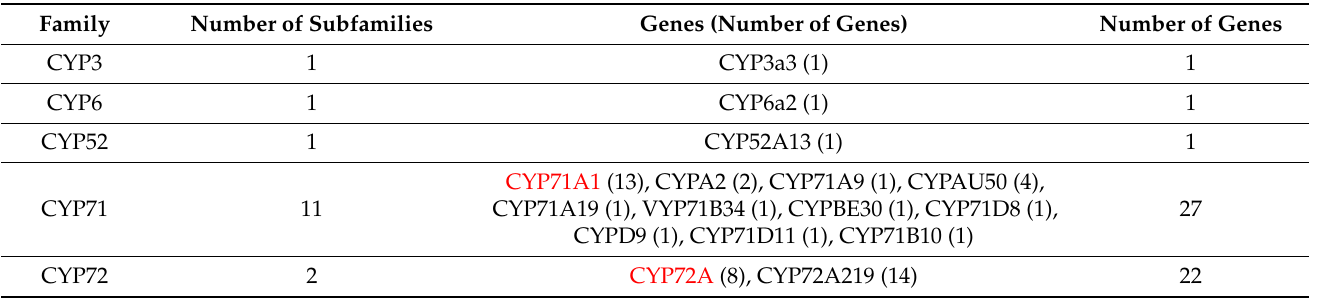
Table 4. CYP monooxygenase families in C. robustum